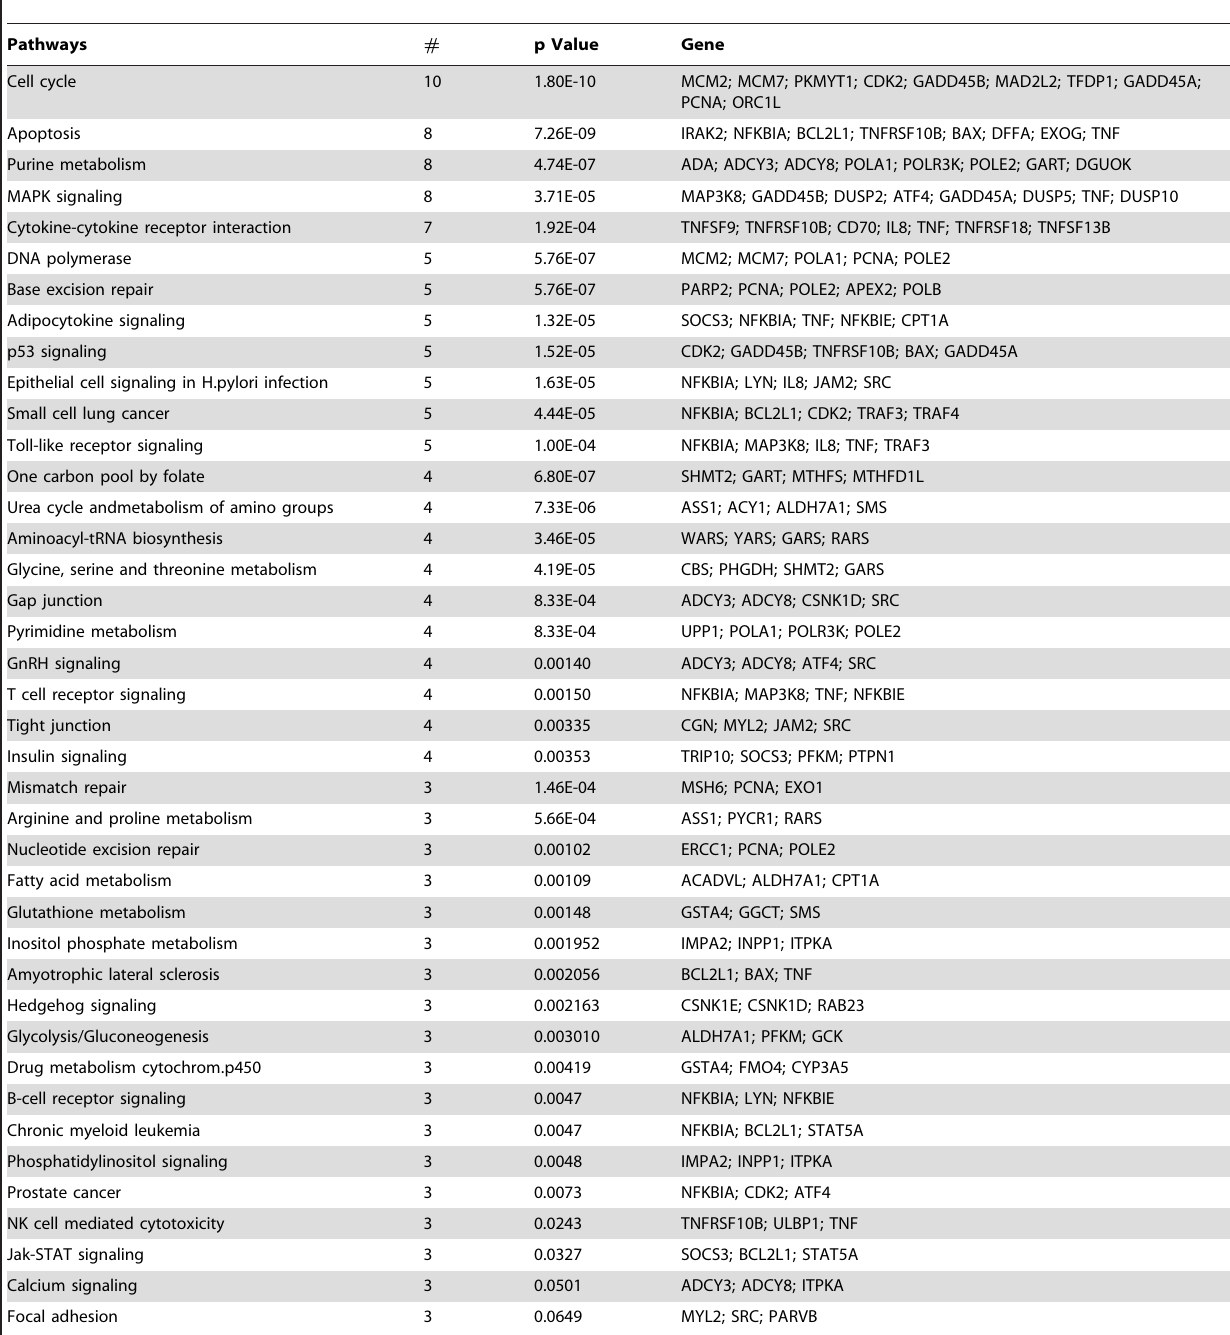
Table 4. Genes downregulated in the HIV-1 infected culture compared to uninfected control cells determined by transcriptome